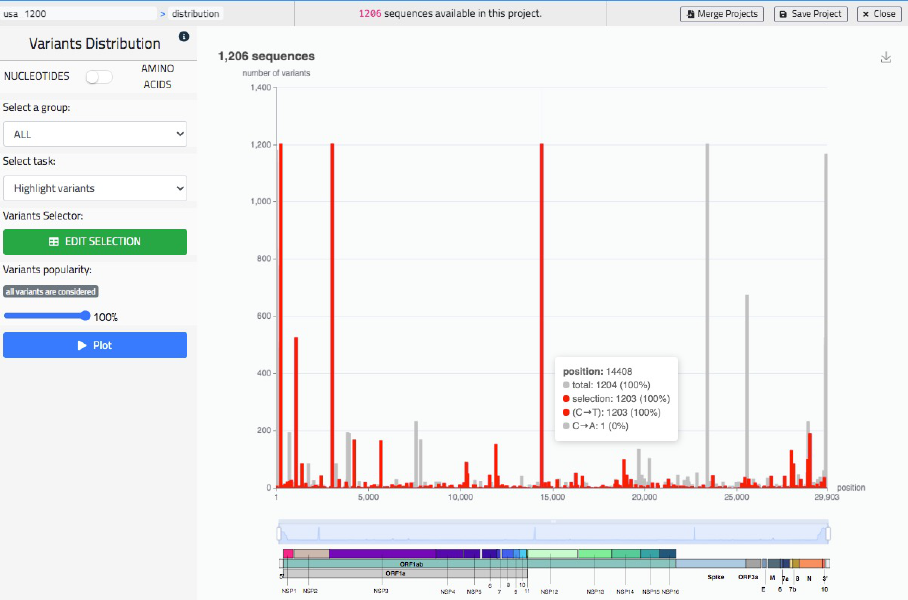
Figure 7. The ‘Distribution’ screen of VirusLab, a visual representation of the variants’ distribution in the uploaded